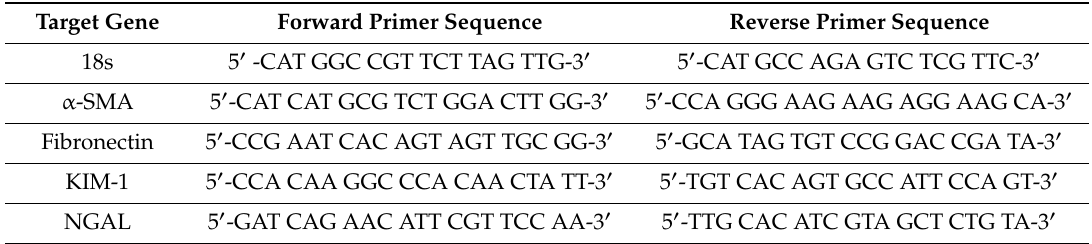
Table 2. Quantitative PCR (qPCR)